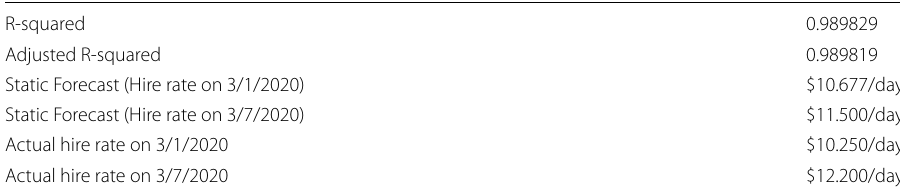
Table 8 Six-months timecharter 75.000 dwt. Source : Elaboration by the authors R-squared